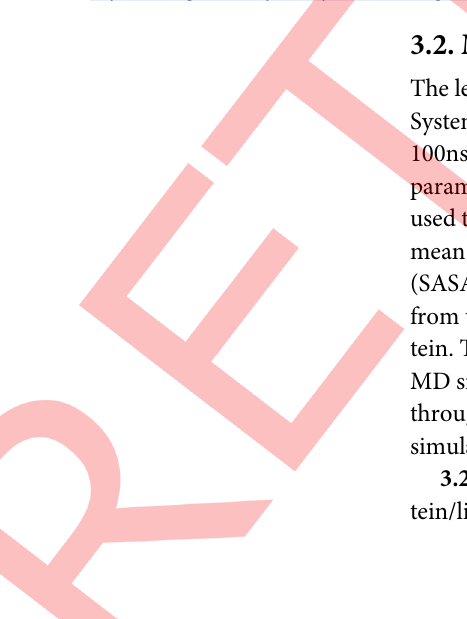
Fig 2. Docked scutellarin & Gentiopicroside/Endothlien-1 with ET-1; side chains atoms of Asn 158, Lys 161, Lys 97 making hydrogen bonds. Docked poses of compound highlighting the most active residues of protein’s binding pocket as shown above.